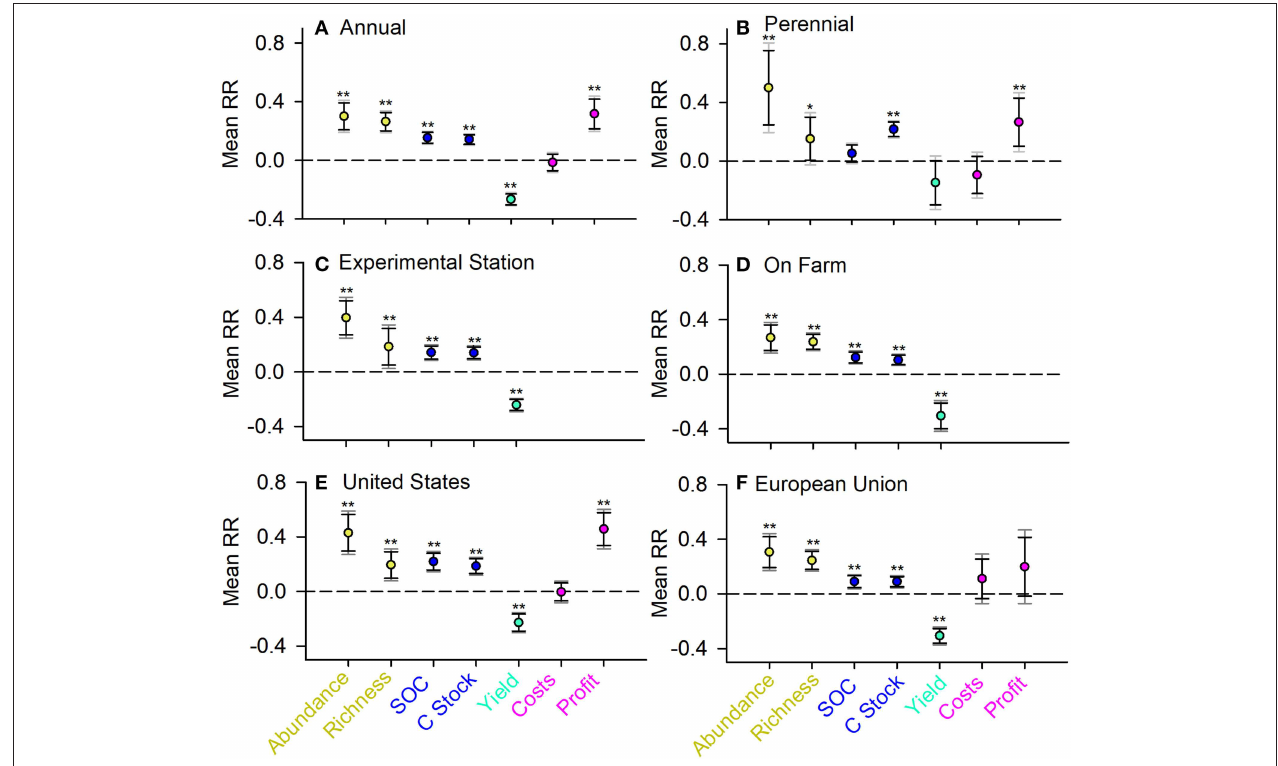
( Figure 2C ; Table 1 ), although the magnitude of effects on yield variability (i.e., log variability response ratios) were more than twice as large as the magnitude of effects on biotic communities ( Table 1 ). In contrast, organic and conventional sites exhibited similar variability in soil organic carbon, carbon stocks, total production costs, and profitability ( Figure 2C ; Table 1 ). Standard deviations in biotic abundance and richness were generally greater on organic farms, but the magnitude of this difference was small in comparison to the large difference in mean biotic abundance and richness in the two farming systems ( Figure 2B ; Figure S4 ). Similarly, organic farming significantly reduced mean yield, but not standard deviation, leading to a higher coefficient of variation ( Figure 2 ; Figure S4